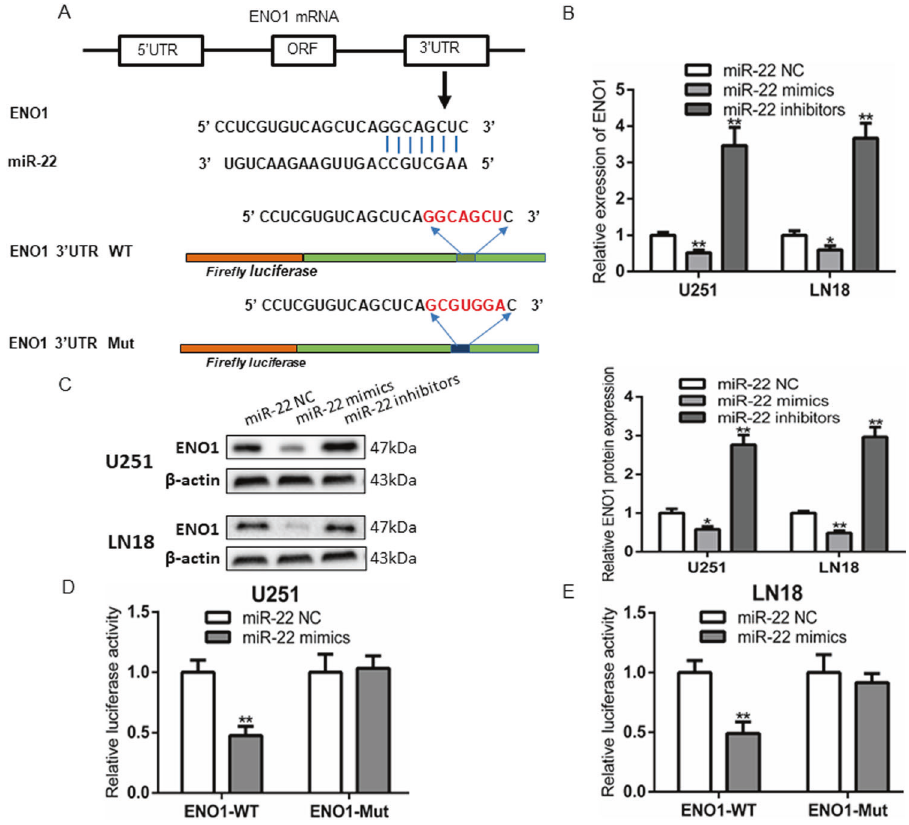
Fig. 6 MiR-22 targets the 3 ’ UTR of ENO1 and inhibits its expression in GBM. A Schematic diagram showing the predicted miR-22 binding sites within the 3 ’ UTR of oncogene ENO1. B, C Relative expression of ENO1 mRNA and protein levels in U251 and LN18 cells after transfected with miR-22 mimics, miR-22 inhibitors, and miR-22 NC. * P < 0.05, ** P < 0.01 vs. miR-22 NC group. D , E Luciferase activity in U251 and LN18 cells co-transfected with miR-22 mimics and luciferase reporters containing ENO1 wild type (WT) or mutant type (MUT) 3 ′ -UTR. ** P < 0.01 vs. miR- 22 NC group. Data are presented as mean ± SD from three independent